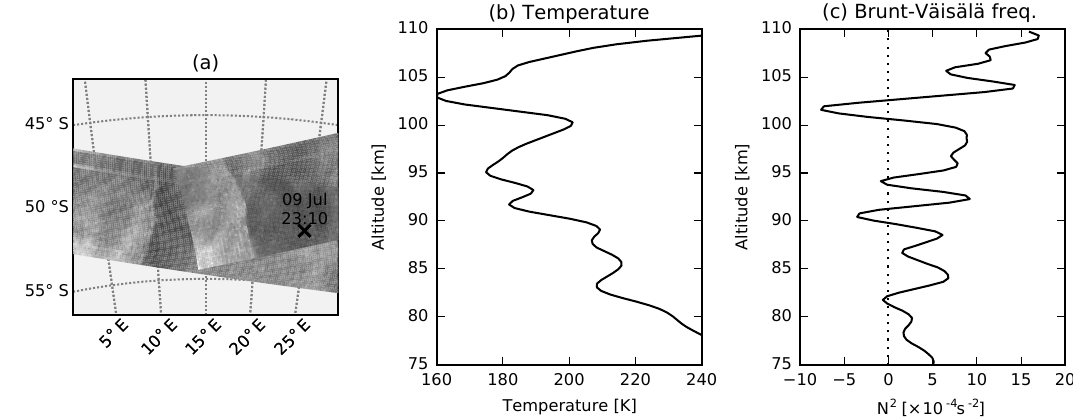
Figure 2. SABER measurements obtained 2.3h after the bore event no. 1. (a) The measurement point at 95km altitude is indicated by the black cross. (b) The altitude profile of temperature showing a 30K temperature inversion at 95–100km altitude. (c) The altitude profile of the resulting Brunt–Väisälä frequency showing a stable layer at 95–100km.